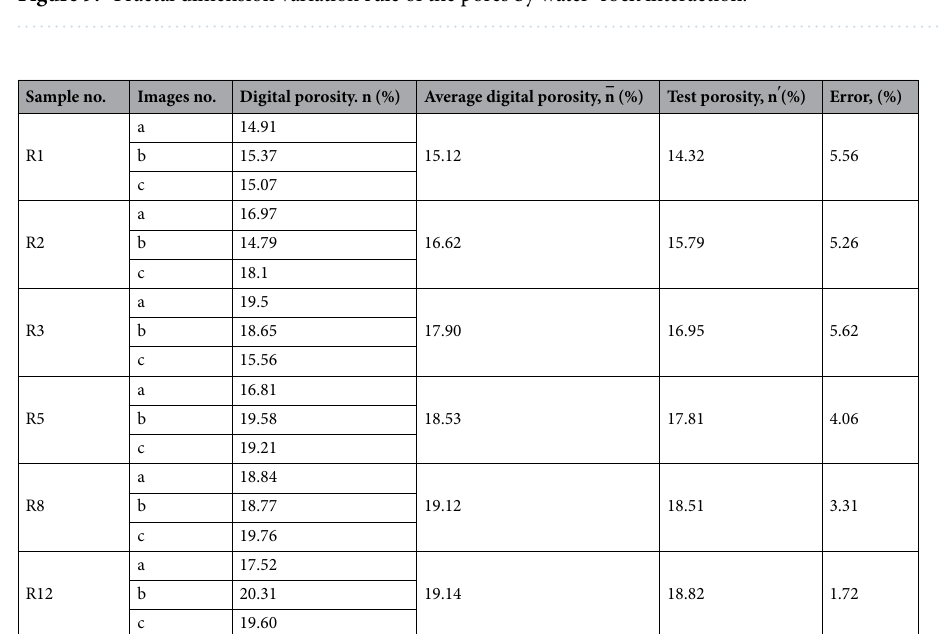
Table 7. Porosity of red-bed soft rock in different water–rock interaction cycles.